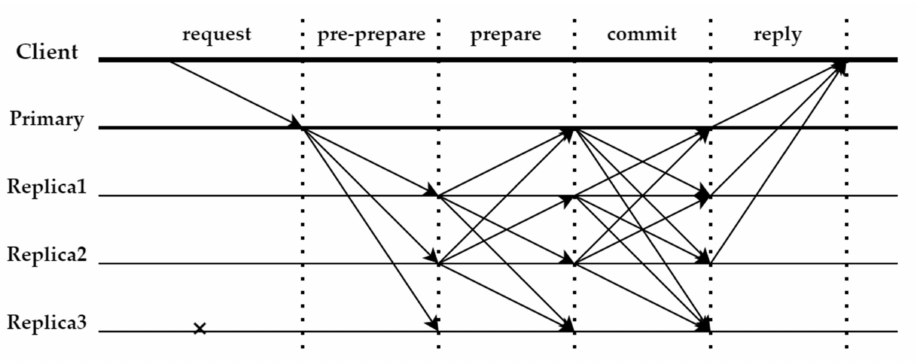
Figure 1. The consensus process of PBFT